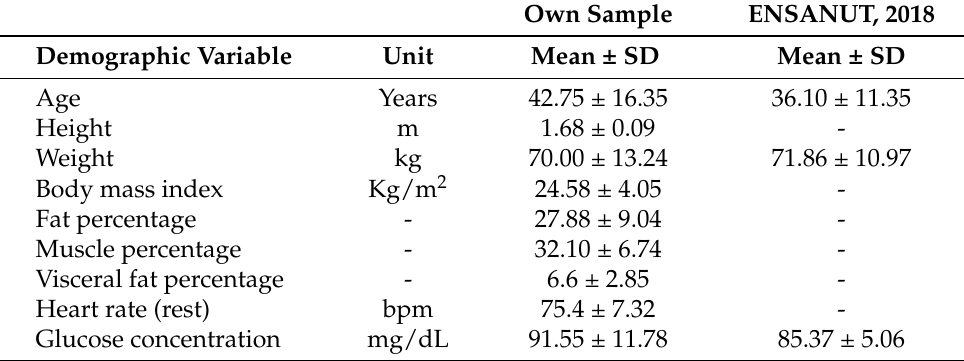
Table 2. Personal characteristics of the participants involved in the